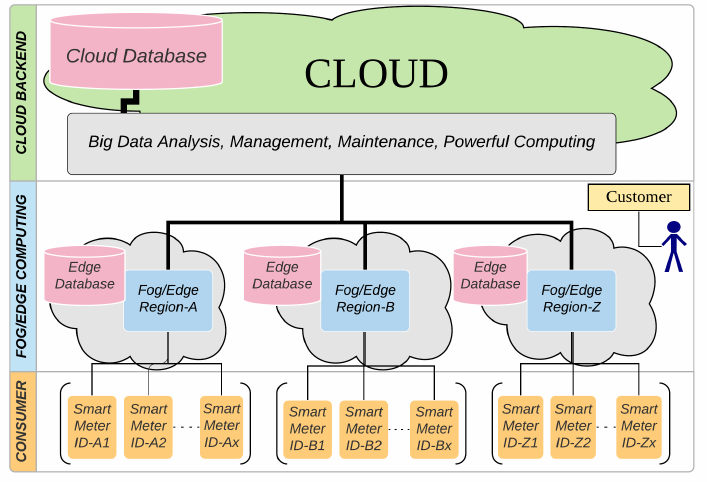
Figure 1. Cloud computing with edge/fog model in the smart